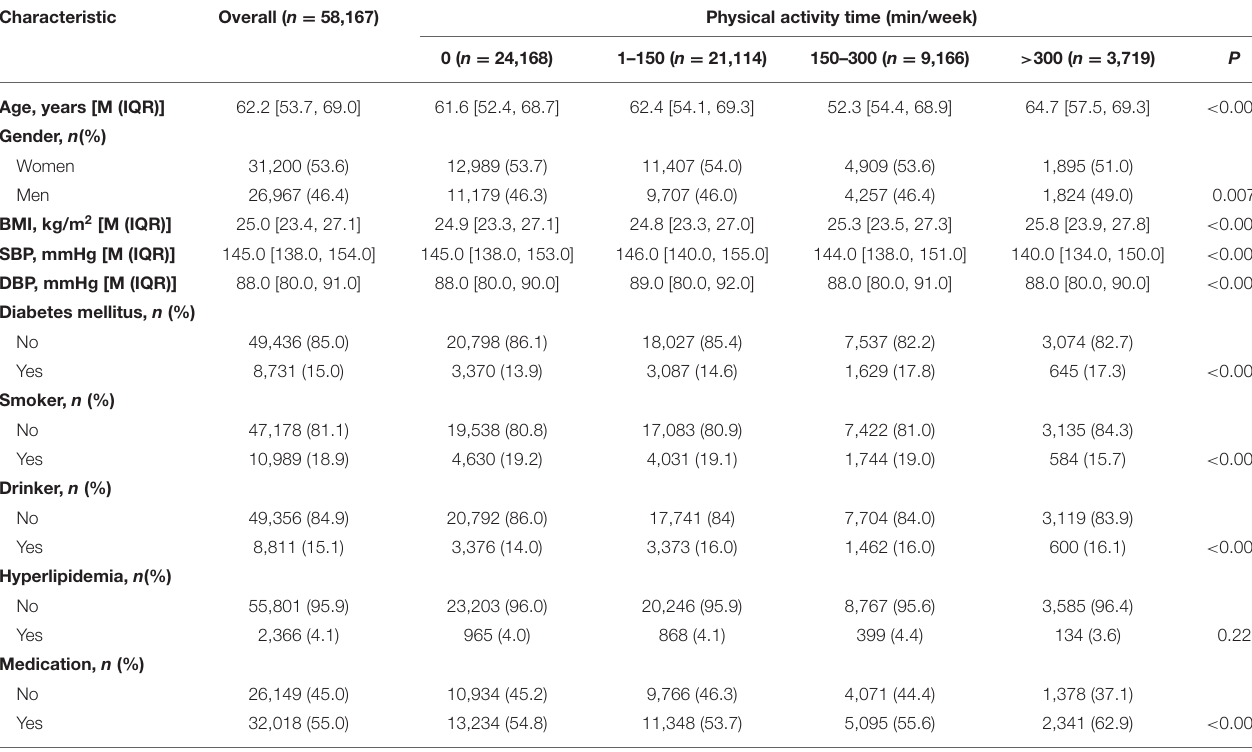
TABLE 1 | Characteristics of the study population by baseline physical activity level.